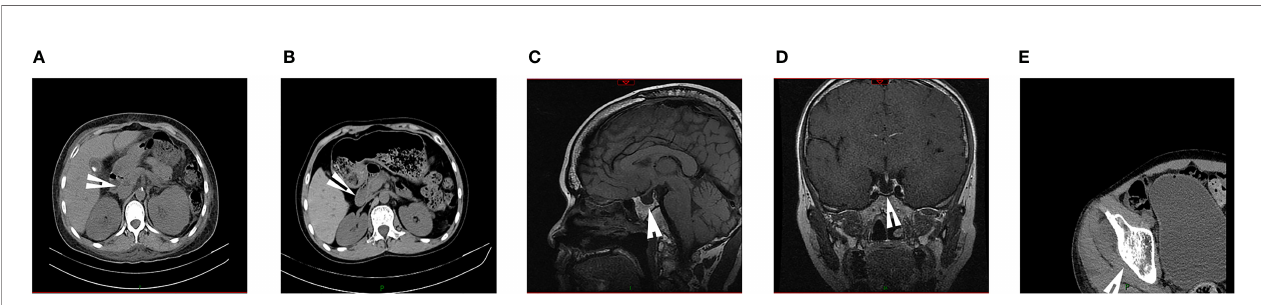
FIGURE 3 | The images of the WSS patients. (A) Computed tomography of the abdomen of the proband demonstrated atrophy of the pancreas. (B) Computed tomography of the abdomen of the brother of proband showed uneven pancreatic density. (C, D) Pituitary MR of the brother of proband indicated the empty sella and none pituitary gland. (E) Hip CT of the brother of proband suggested osteoporosis that was not consistent with actual age. (arrows).